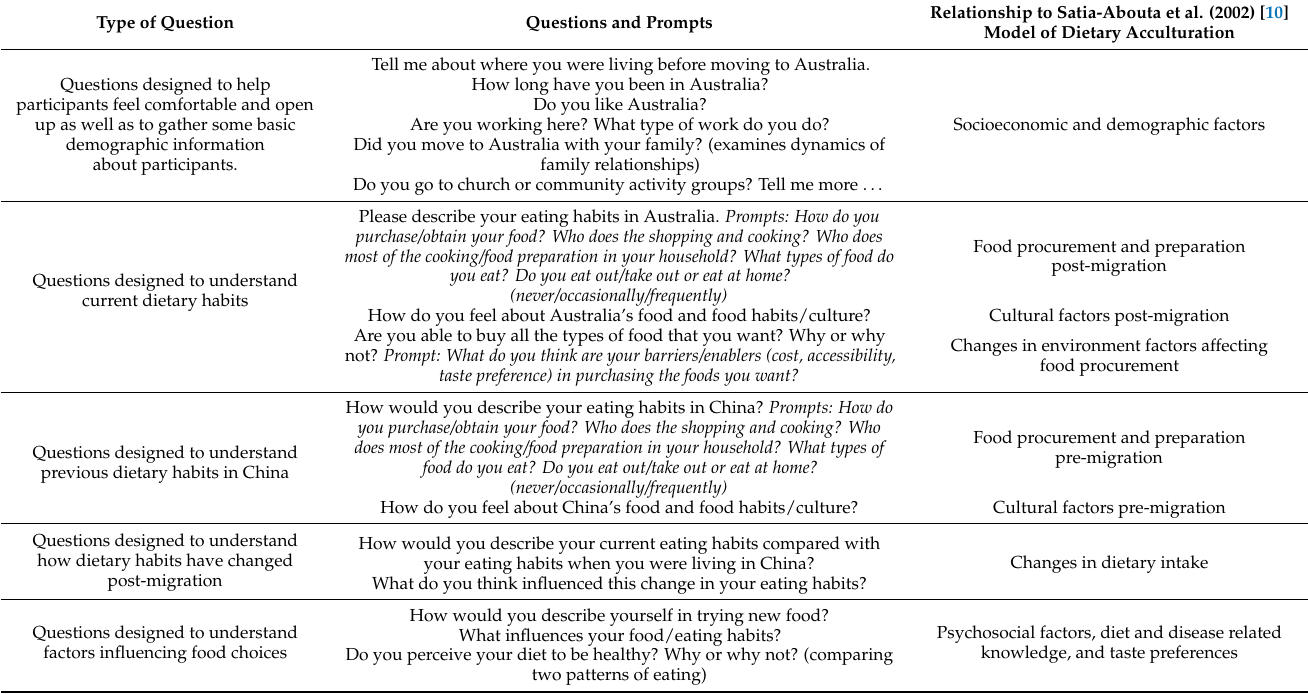
Table 1. Interview guide for semi-structured interviews designed to explore participant’s perspectives of dietary change